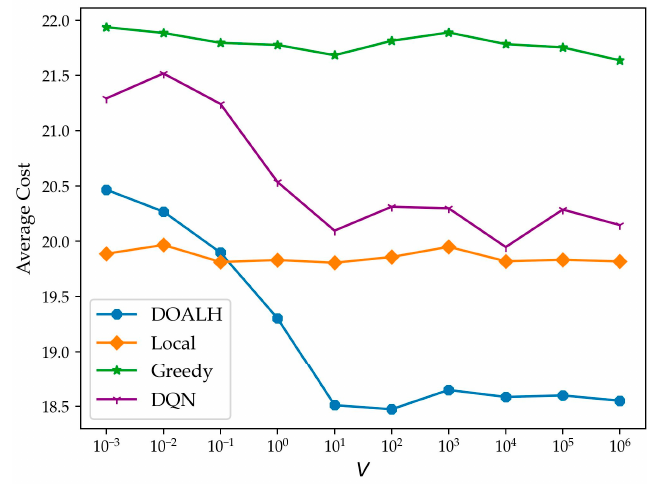
Figure 4. 𝑀 = 50, 𝛽 = 0.1, 𝐵 = 500 (Mb/s) Average 𝐶𝑜𝑠𝑡 vs. 𝑉 .